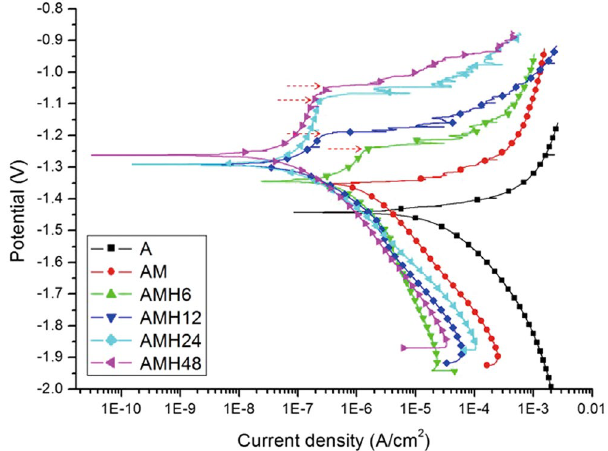
Figure 3. Potentiodynamic polarization curve of the A-, AM-, AMH6-, AMH12-, AMH24- and AMH48- treated surfaces.